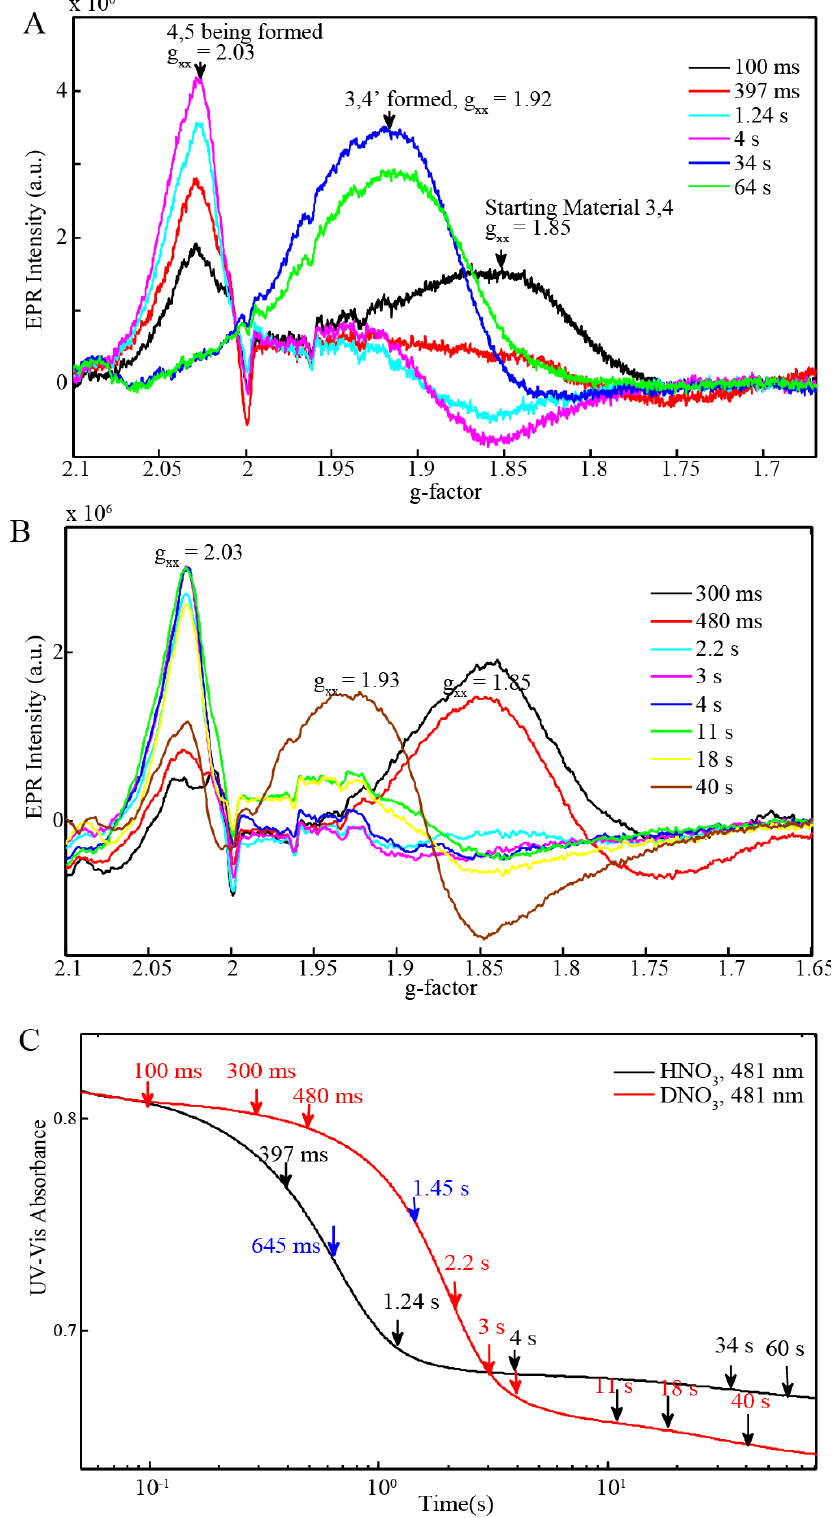
Figure 6. ( A ) X-Band EPR of 0.25 mM BD[3,4] with 20 equiv Ce(IV) in H freeze-quenched at different time intervals; ( B ) X-Band EPR of 0.25 mM BD[3,4] with 20 equiv Ce(IV) in D O freeze-quenched at different time intervals; ( C ) UV-Vis 2 absorbance curve at 481 nm showing times at which samples were freeze-quenched in H O (The inflection points of both absorbance curves are shown in and D 2